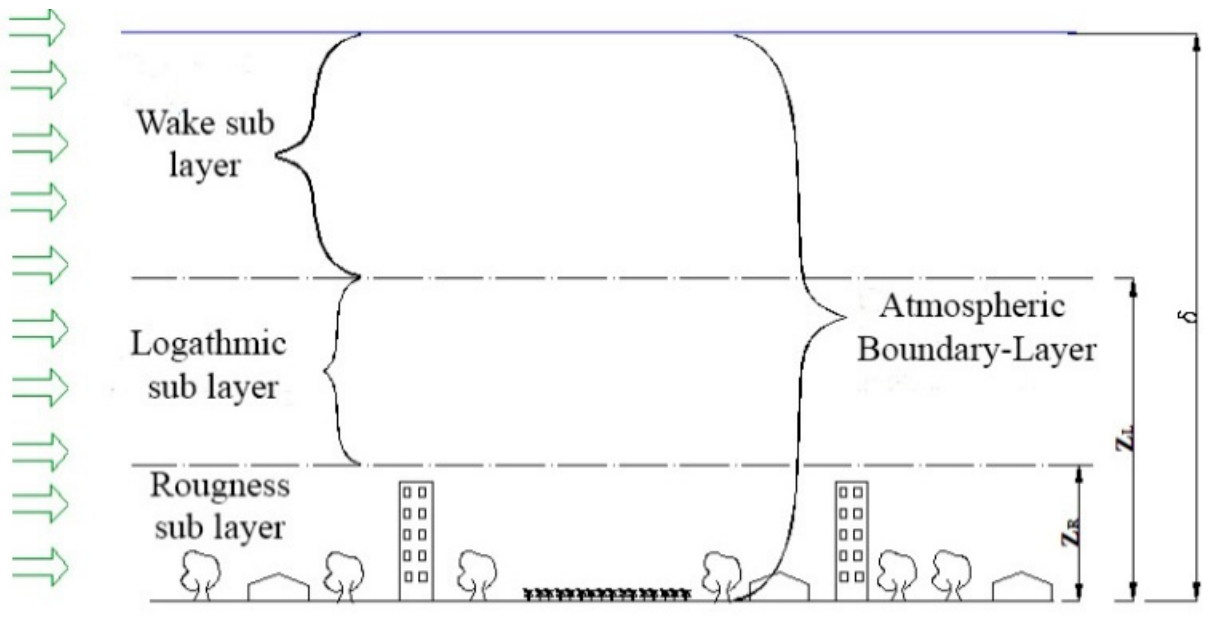
Figure 1. Atmospheric boundary layer sublayers.